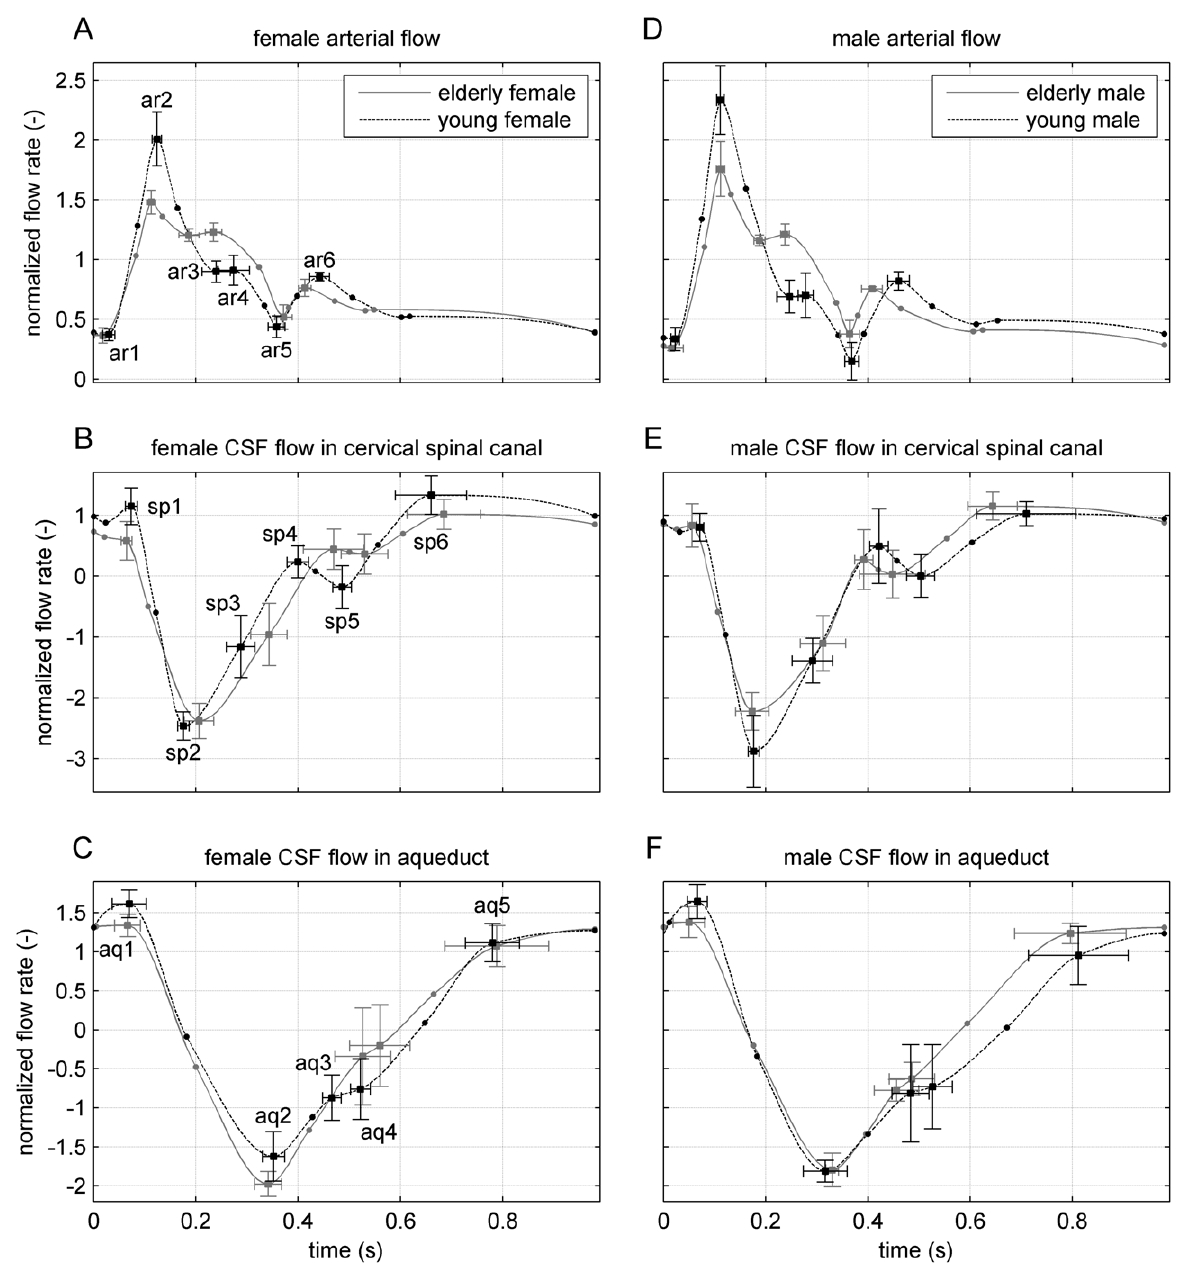
Figure 1. Feature points with corresponding standard deviation (SD) error bars and piecewise cubic Hermite interpolated polynomial fits [ 22 ] of arterial and cerebrospinal fluid (CSF) flow in the elderly (gray line) and young groups (dashed black line) as a function of time. The left column A – C shows results for females, right for males D – F . Top row: Sum of mean (over subjects) normalized flow velocity curves in the left and right common carotid arteries and the left and right vertebral arteries. Middle row: Mean CSF flow in the cervical spinal canal at the level of C3–C4 (between the third and fourth vertebrae). Positive values correspond to flow in cranial direction. Bottom row: Mean CSF flow in the aqueduct (positive values: cranial flow). In panels A and D , the feature points are labeled ar1–ar6, in B and E sp1–sp6 and in C and F aq1– aq5 (Table 2).